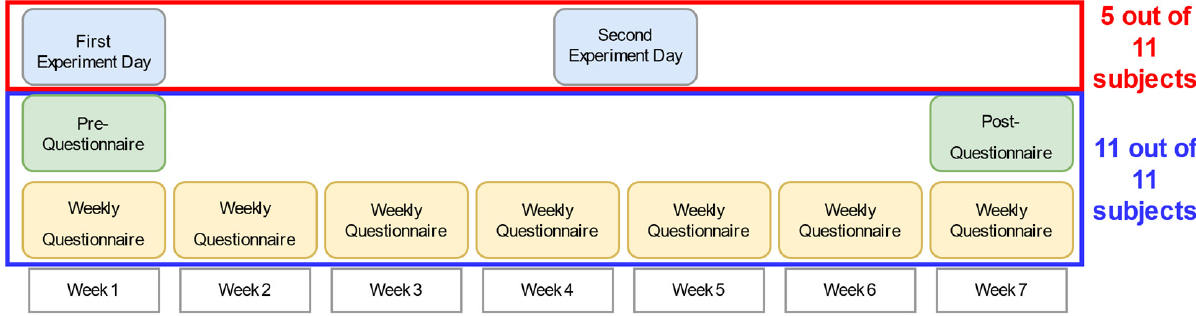
Figure 2. The overall schedule and structure of the study: The weekly questionnaires were filled in by all eleven subjects and five of the eleven subjects additionally took part in behavioural experiments at the beginning and after four to five weeks of the study.